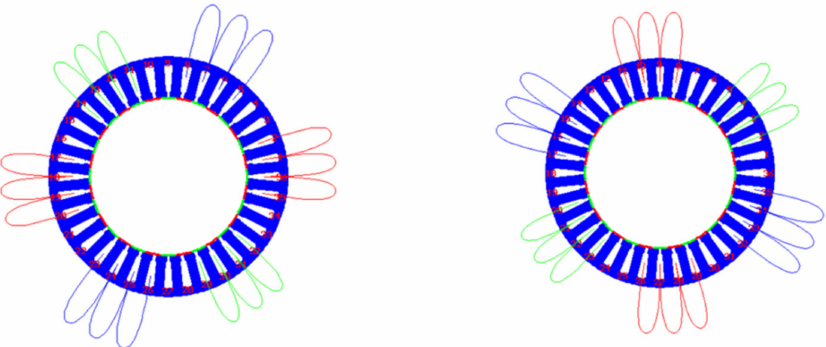
Figure 7. Second example of a winding system that allows a geometrical decoupling of the main- and redundant winding system (winding scheme by placing the main and redundant parts alternately: 3 coils main and 3 coils redundant, always